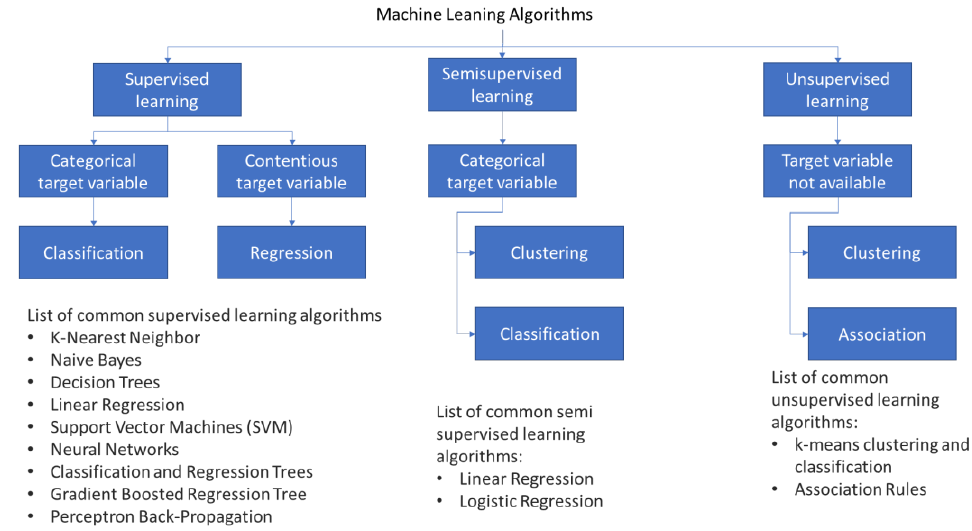
Figure 1. Machine learning algorithms’ classification.